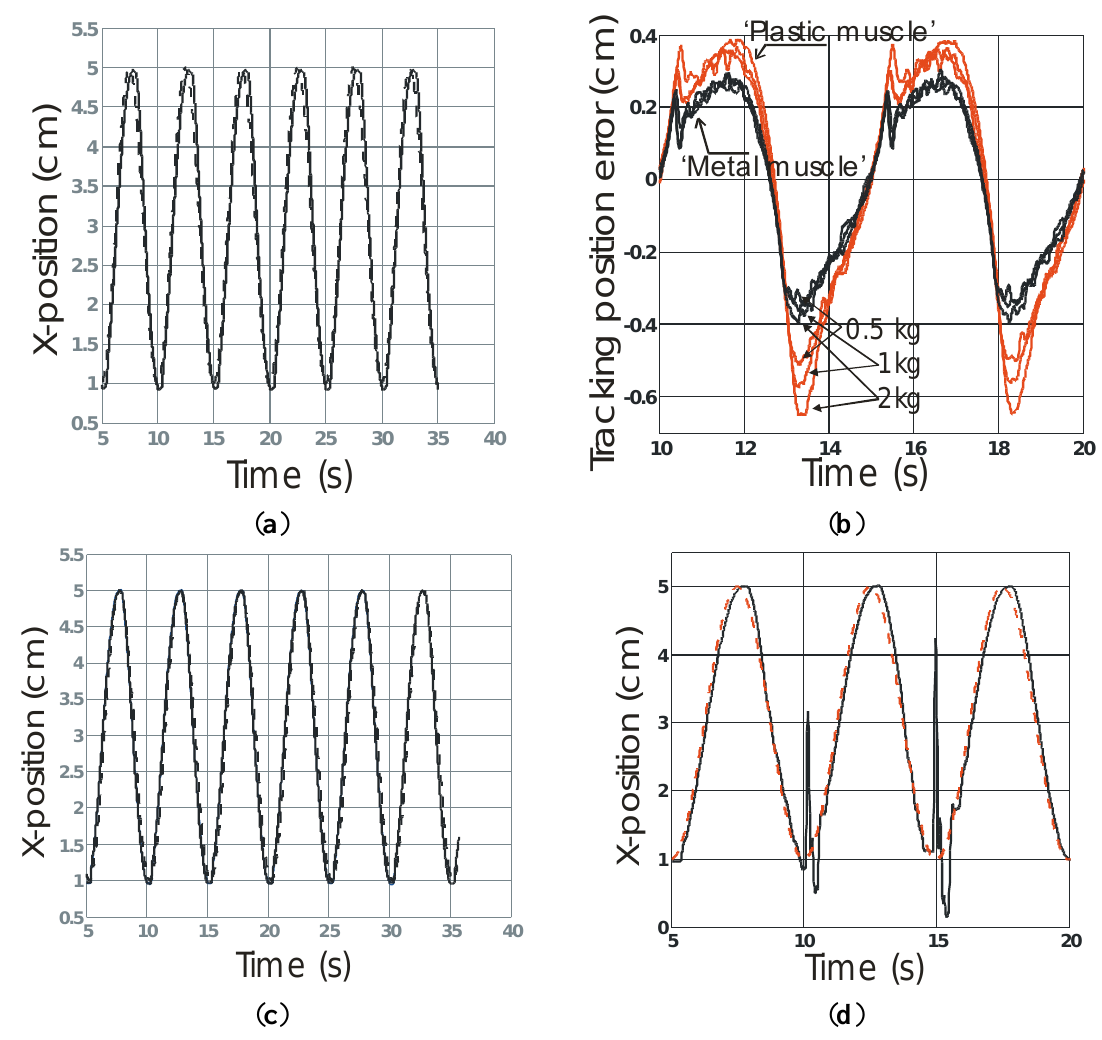
the plastic and metal wire-braided McKibben muscle, ( a ) McKibben muscle made of a plastic sheath driving a 1 kg load; ( b ) McKibben muscle made of a metal sheath driving a 1 kgload; ( c ) Comparison of tracking position errors for three embedded loads equal to 500 g, 1 kg and 2 kg; ( d ) Effect of manual perturbations during closed-loop control movement in the case of the metal sheath McKibben